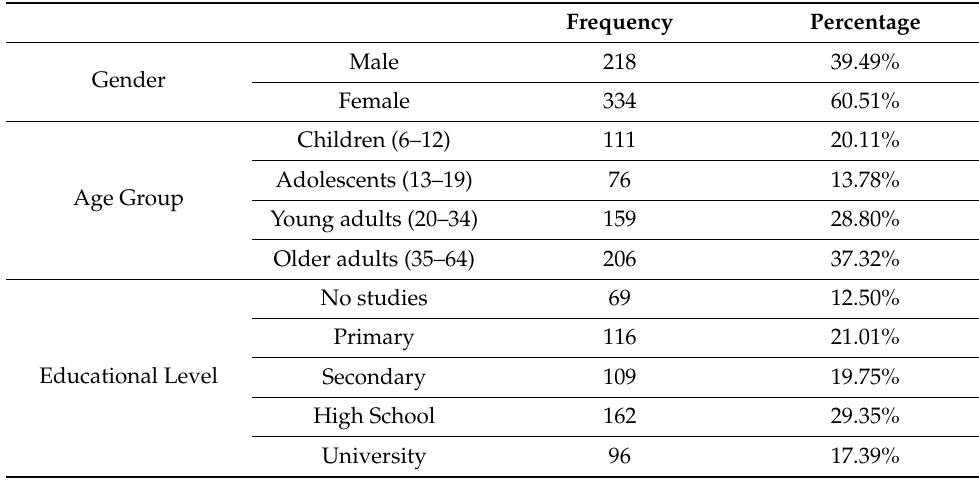
Table 1. Distribution per socio-demographic